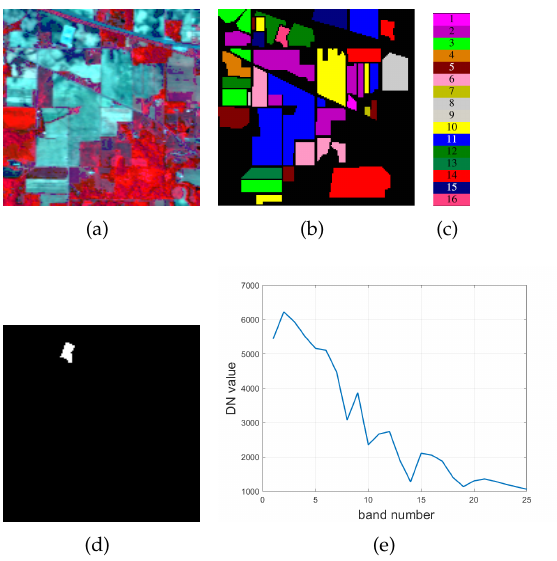
Figure 9. For the Indian Pines data with 200 bands, ( a ) the false color image (R:Band 44, G:Band 31, B:Band 18); ( b ): groundtruth data with 16 classes; ( c ): the groundtruth image for the 16th class; ( d ): the selected spectrum of the target.